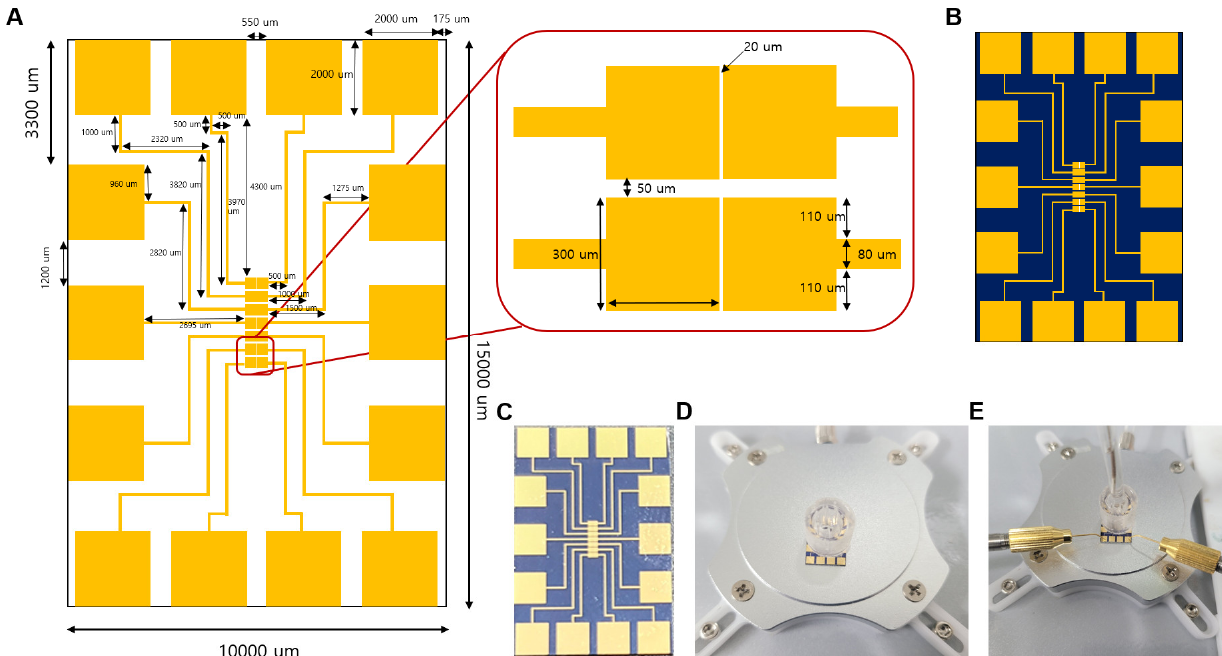
Figure 2. ( A ) Designed image of the Au microgap electrode. ( B ) Image of the Au microgap electrode. ( C ) Photo image of the Au microgap electrode. ( D ) Photo image of the Au microgap electrode with the working chamber. ( E ) Photo image of electrochemical measurement with a probe tip in the working solution.